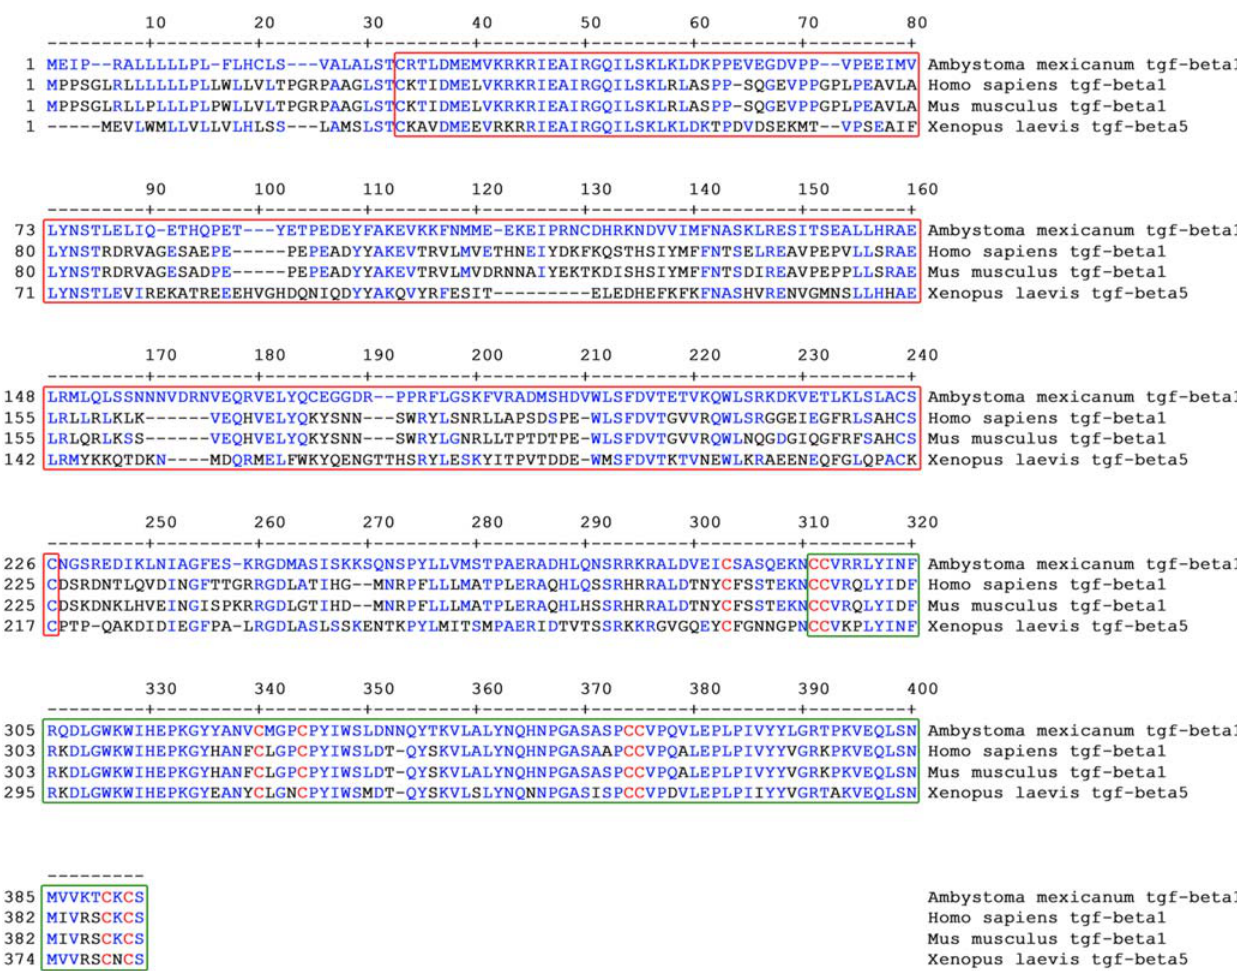
Figure 1. Axolotl TGF- b 1 protein sequence and domains. Alignment of axolotl ( Ambystoma mexicanum ) TGF- b 1 amino acid sequence with TGF- b 1 sequences of human ( Homo sapiens ), mouse ( Mus musculus ) and TGF- b 5 of Xenopus ( Xenopus laevis ). In blue are residues of the axolotl sequence that are conserved in the other three sequences. In red are the 9 conserved cysteine residues found in every TGF- b 1 sequence. The red box identifies the pro-domain of the protein. The green box identifies the mature TGF- b domain of the